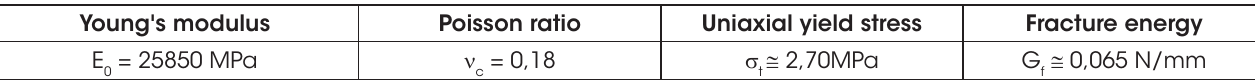
Material parameters obtained by Winkler et al. [5]